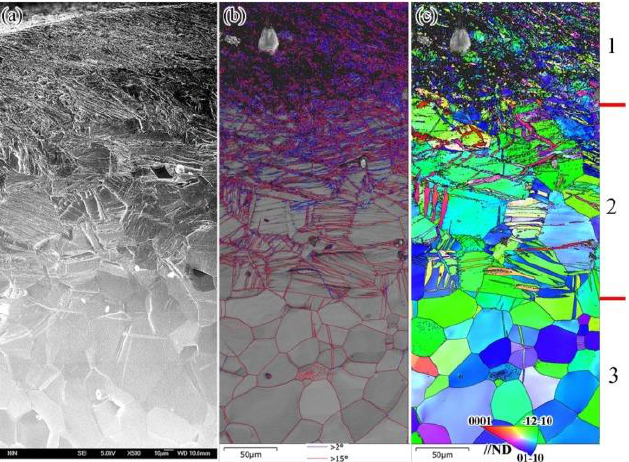
Figure 6. Gradient microstructure after USRP on pure titanium: ( a ) SEM, ( b ) grain boundary orientation map, and ( c ) inverse pole figure map. Reprinted with permission from ref. [34]. Copyright 2022. Elsevier.